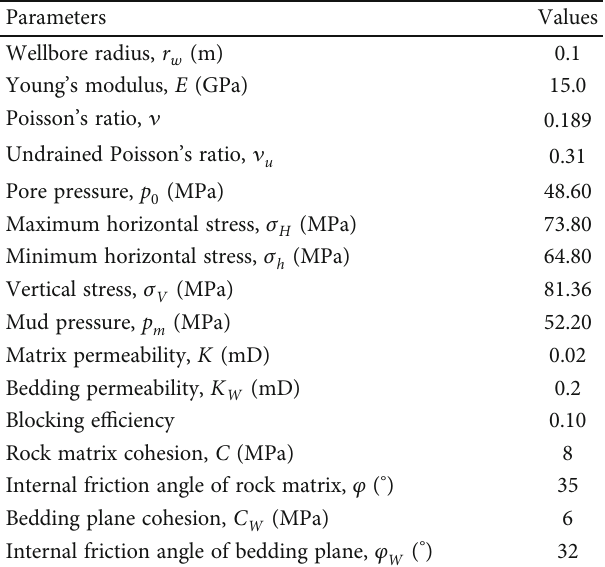
Figure 21: Geometry and mesh of the fi nite element model for the wellbore analysis considering fl uid fl ow along the bedding planes as well as strength degradation of the bedding planes. Table 8: Parameters used in the fi nite element